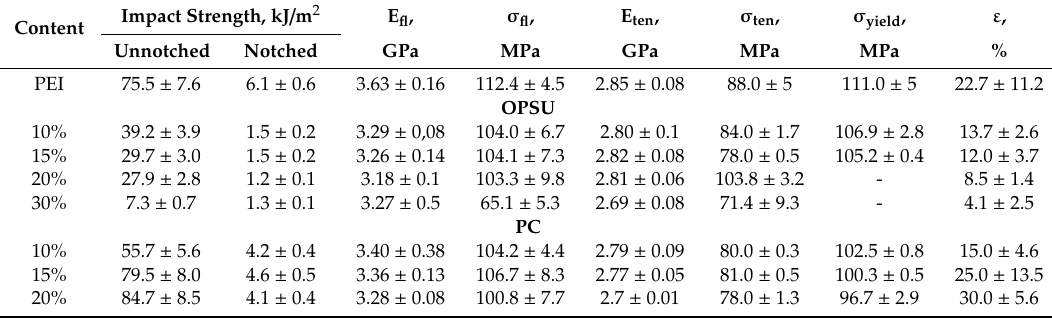
Table 1. Mechanical properties of the blends PEI / OPSU and PEI / PC.